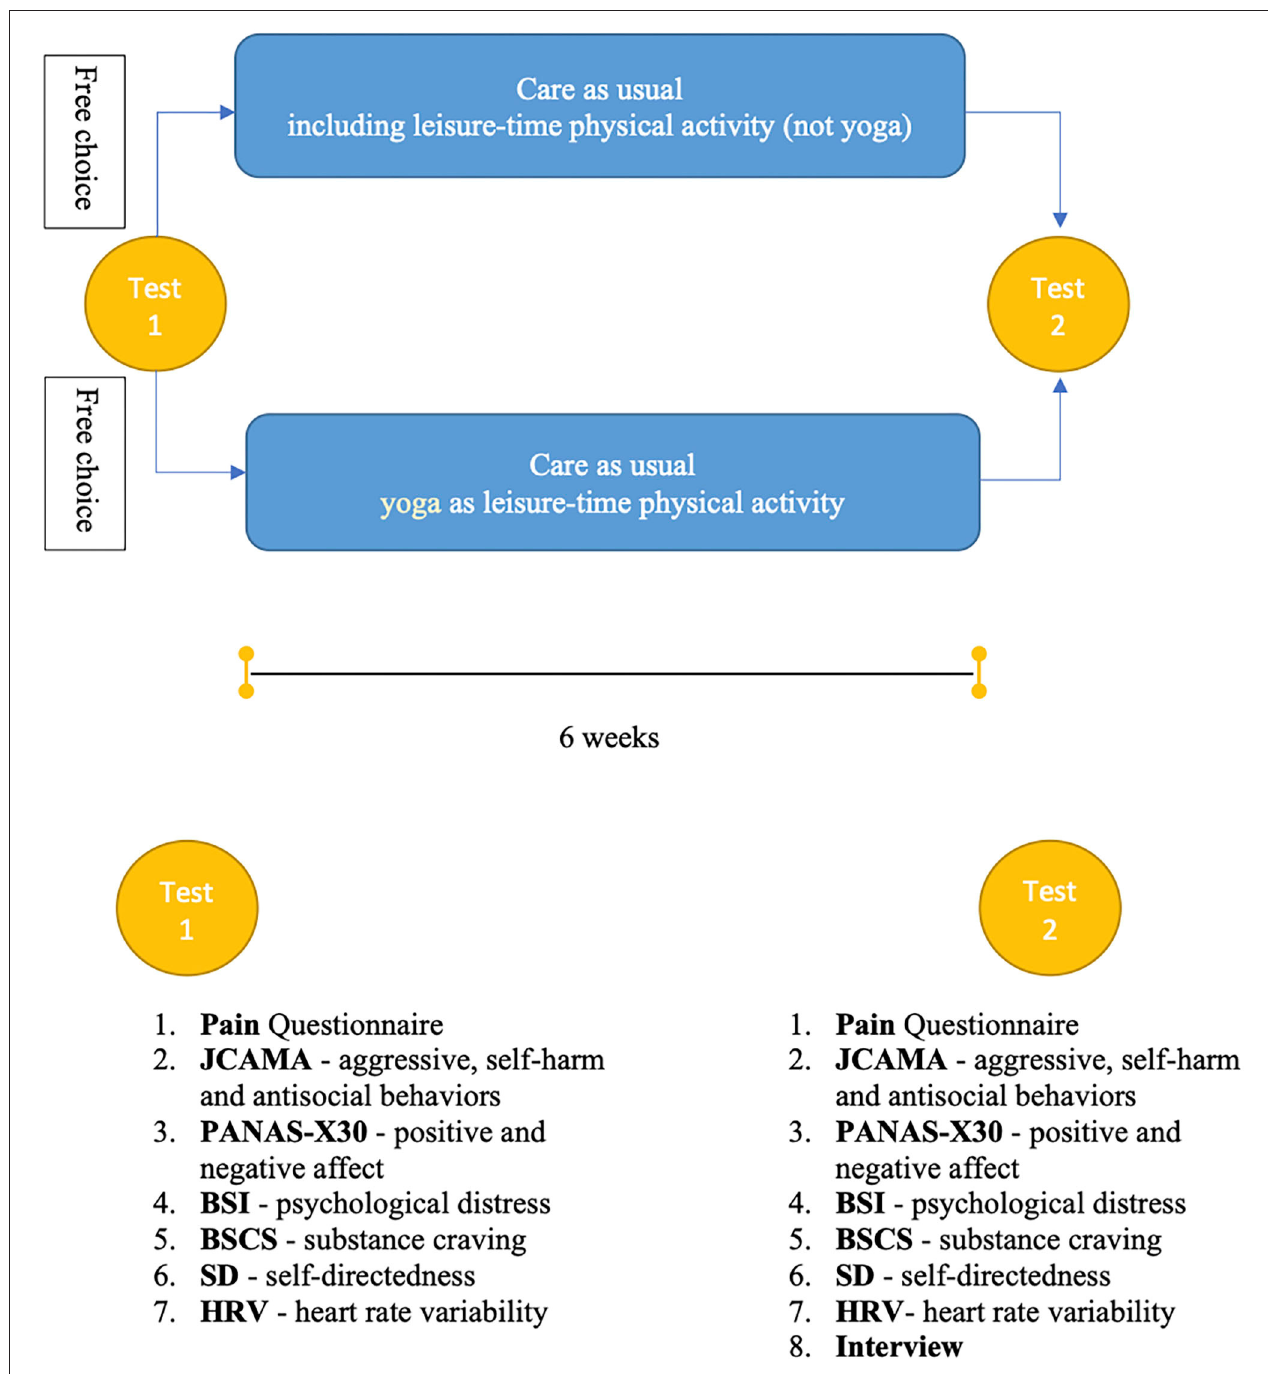
FIGURE 2 | Flowchart of the quasi-experimental study design, and list of the included measures at pre- and post-intervention.